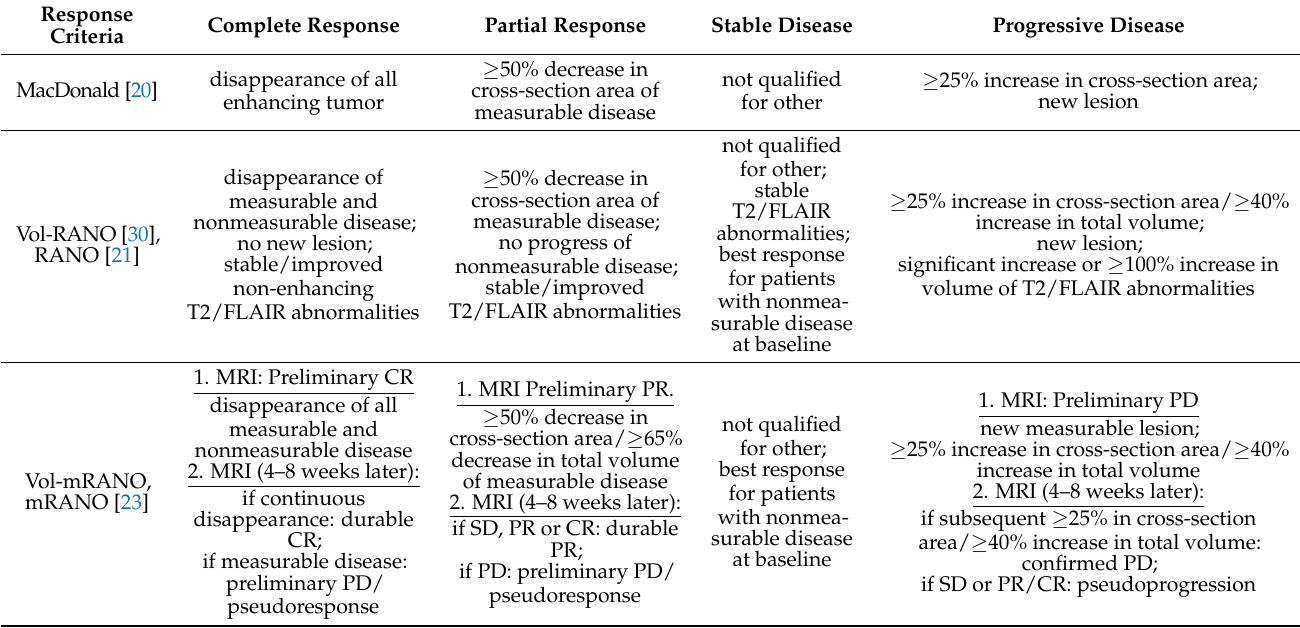
Table 1. Summary of response-assessment